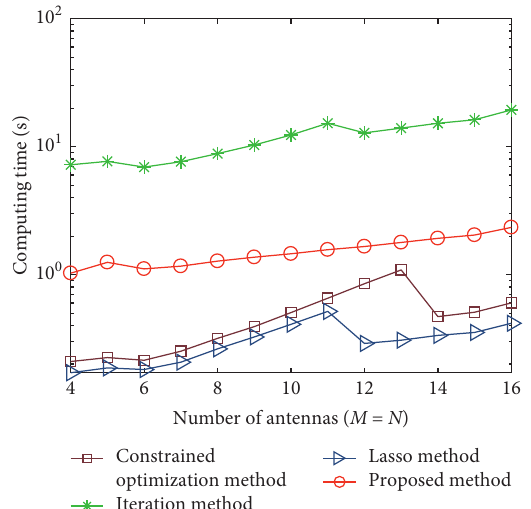
Figure 3: Computing time of the methods against the number of antennas when SNR � 20dB.